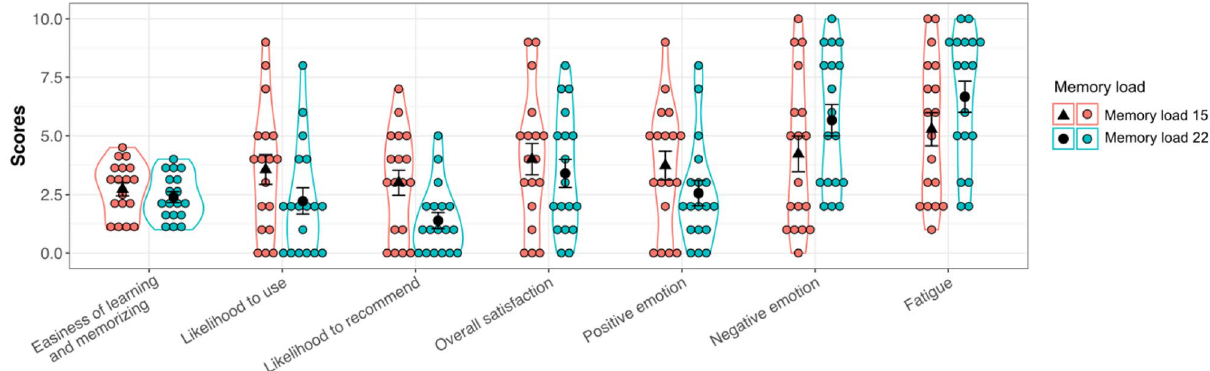
Figure 3. Mean subjective rating scores of gestures. Black triangles and dots represent mean scores of subjective ratings in the memory load 15 and memory load 22, receptively. Jittered dots in red and those in green are rating scores for each user in the memory load 15 and memory load 22, respectively. Error bars indicate the standard error of the